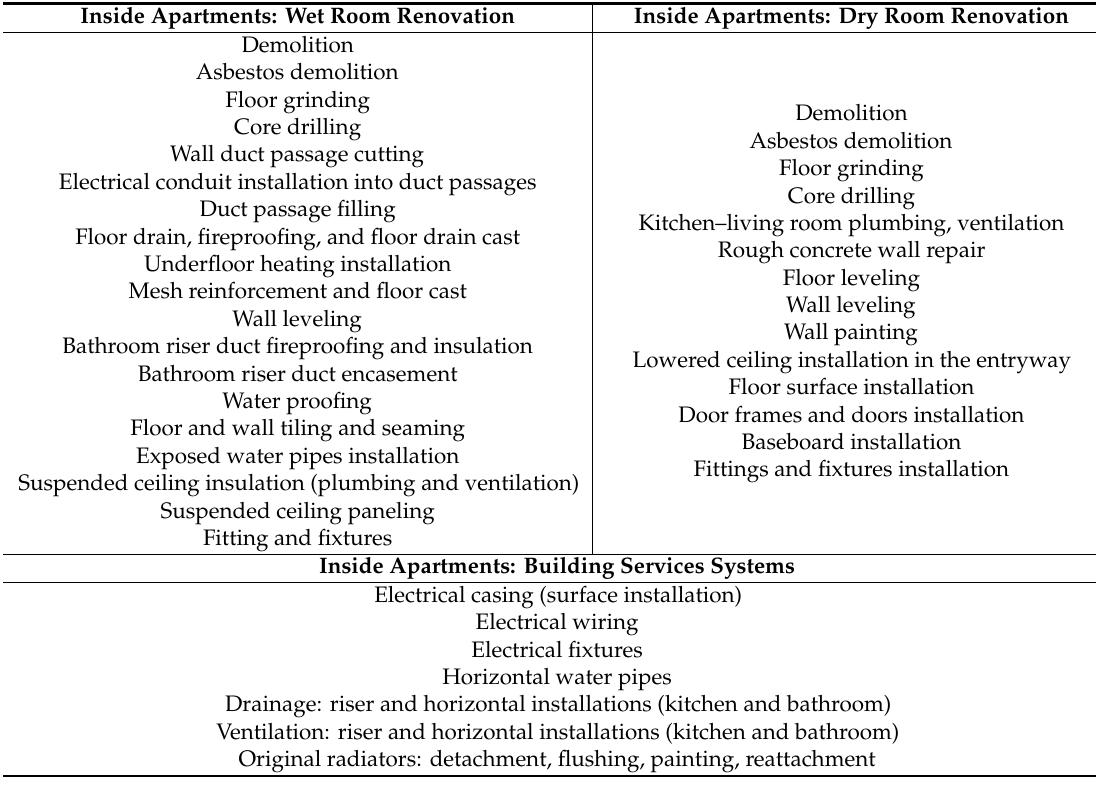
Table 3. Takt work in the apartments in the case